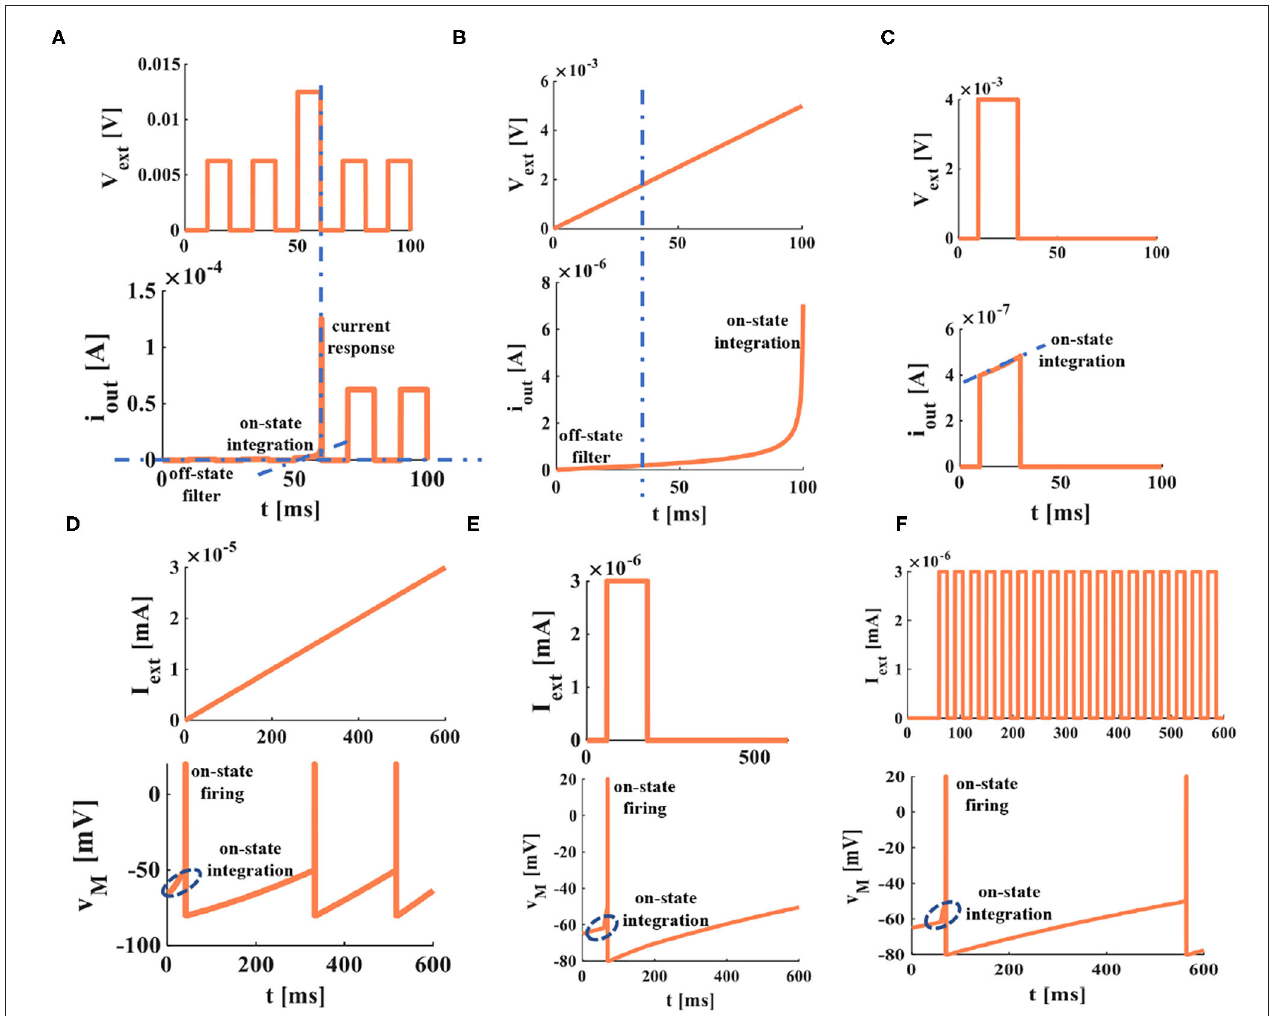
FIGURE 7 | Memristive dendrite and memristive soma. (A) The non-linear filtering and integration of dendrite. (B) The non-linear integration of dendrite. (C) The current response of memristive dendrite in on and off states. (D) The voltage response of a ramp current applied on the memristive soma. (E) The voltage response of a single current pulse applied to the memristive soma. (F) The voltage response of a series of current pulses applied to the memristive soma [each plot in this figure is divided into the figure above (the external stimulus applied to the memristor) and the figure below (the response of a memristor to the external